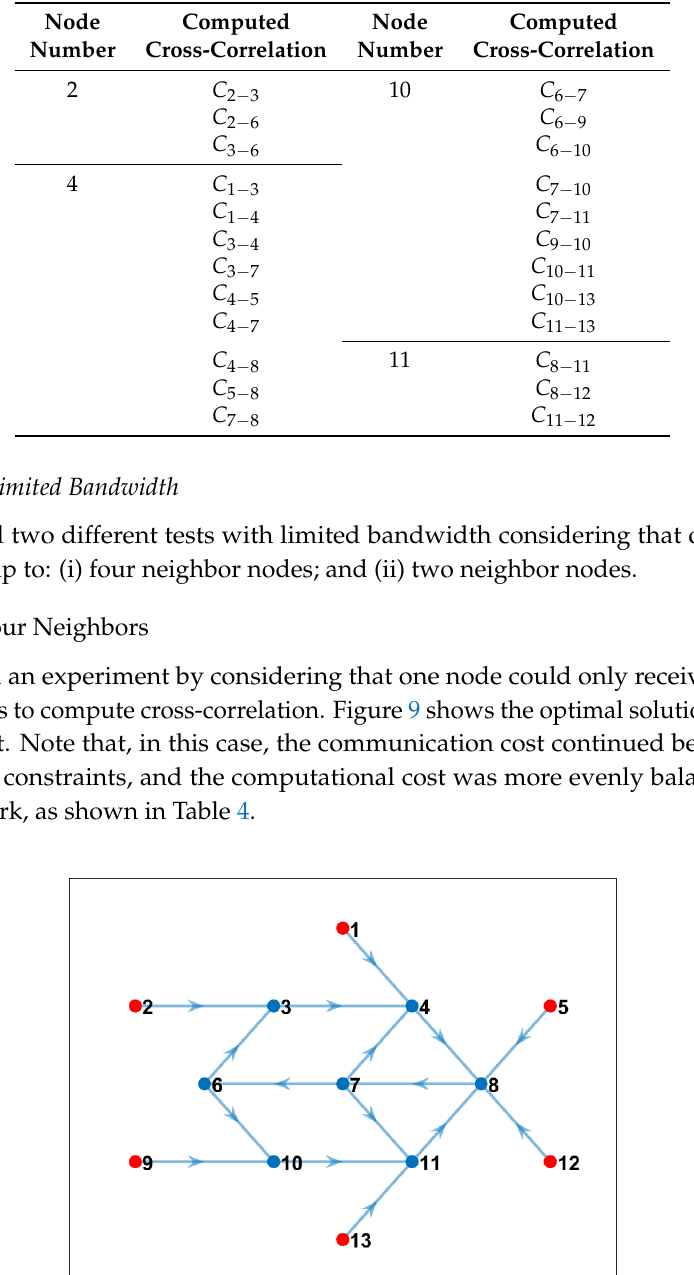
Table 3. Number of cross-correlations for each selected node (unlimited bandwidth).